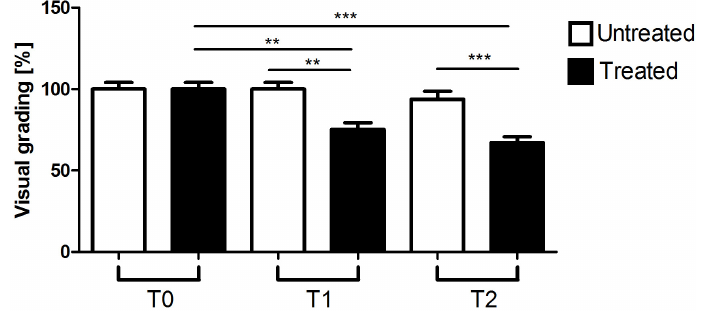
Figure 6. Visual grading of signs of ageing at baseline (T0), after one application (T1) and after 4 applications (T2) of the test product in the clinical trial subjects. Untreated (in white) and treated (in black) sides are shown. *** indicates P < 0.0001, ** indicates P < 0.001.